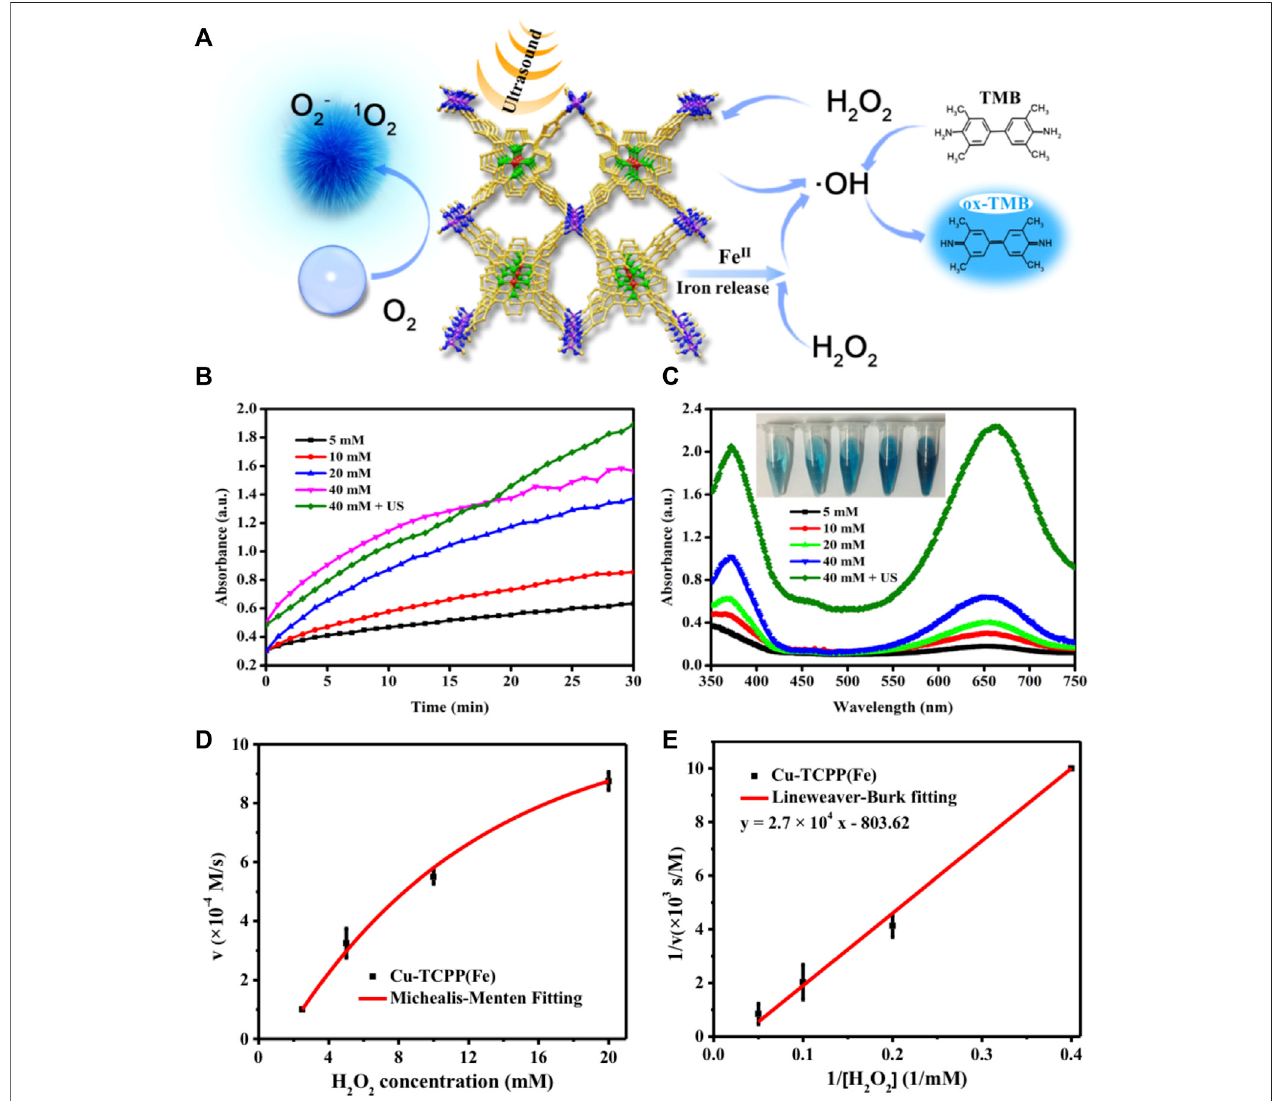
FIGURE3| Invitro characterizationsofthecatalyticperformanceofCu-TCPP(Fe). (A) SchematicillustrationofthemechanismofROSgenerationbyemployingCu- TCPP(Fe) as sonosensitizer for SDT (left) and chemical catalyze (right). (B) The absorbance of Cu-TCPP(Fe) over time after the addition ofvaried concentrations ofH 2 O 2 (40,20,10,and5 mM)andthetriggerofUS(1.0MHz,1.5 W/cm 2 ,50%dutycycle,1 min)atpH=6.0,with0.8 mg/mlTMBand20 μ g/mlCu-TCPP(Fe). (C) Absorbance spectra changes ( λ max = 650 nm) at the end of the reaction (inset shows the photographs of ox-TMB). (D) Michaelis-Menten kinetics and (E) Lineweaver-Burk plotting of